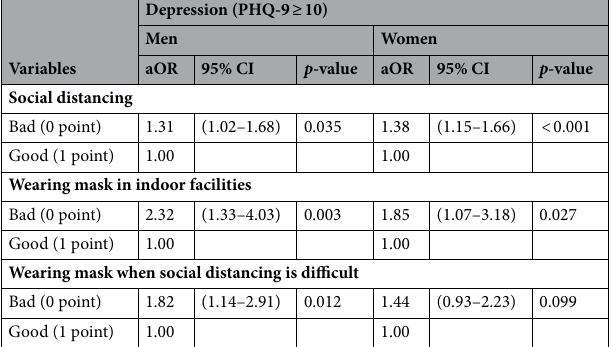
Table 3. Association of social distancing and wearing mask with depression. Adjusted with all covariates. PHQ-9 Patient Health Questionnaire-9; aOR adjusted odds ratio; CI confidence interval.